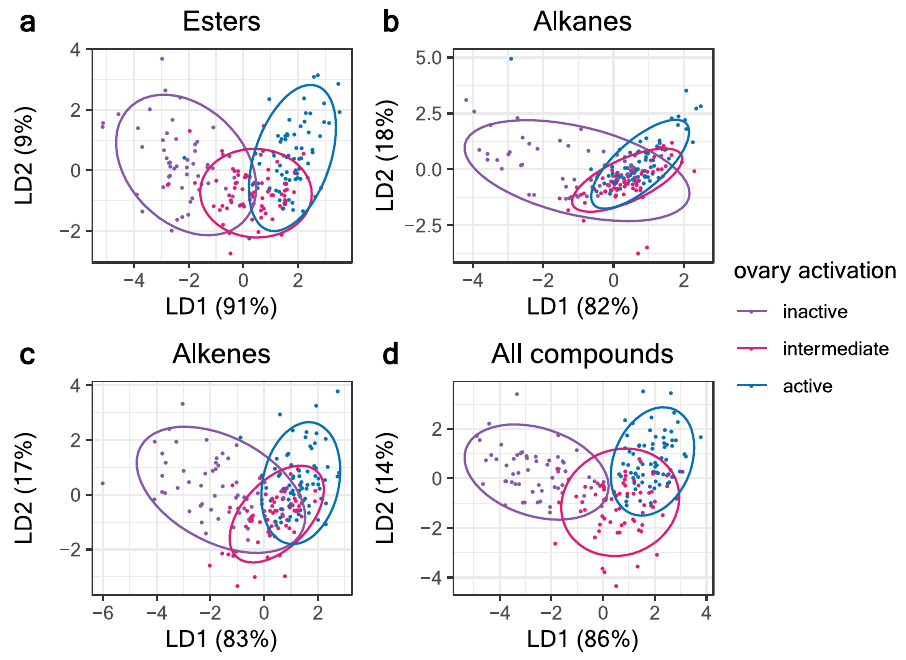
Figure 3. Linear discriminant analyses on Z-transformed relative peak areas of Dufour’s gland extracts of workers with three ovarian activation categories as the grouping variable. Each point is the value from an individual bee. Panels ( a – d ) show the clustering generated by plotting the first two linear discriminant functions using esters, alkanes, alkenes, or all